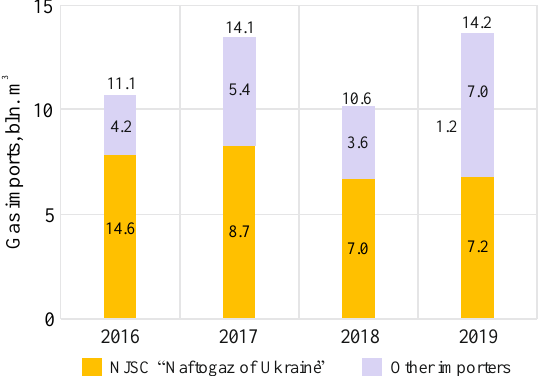
Figure 2. Volumes of natural gas imported to Ukraine in 2016–2019.